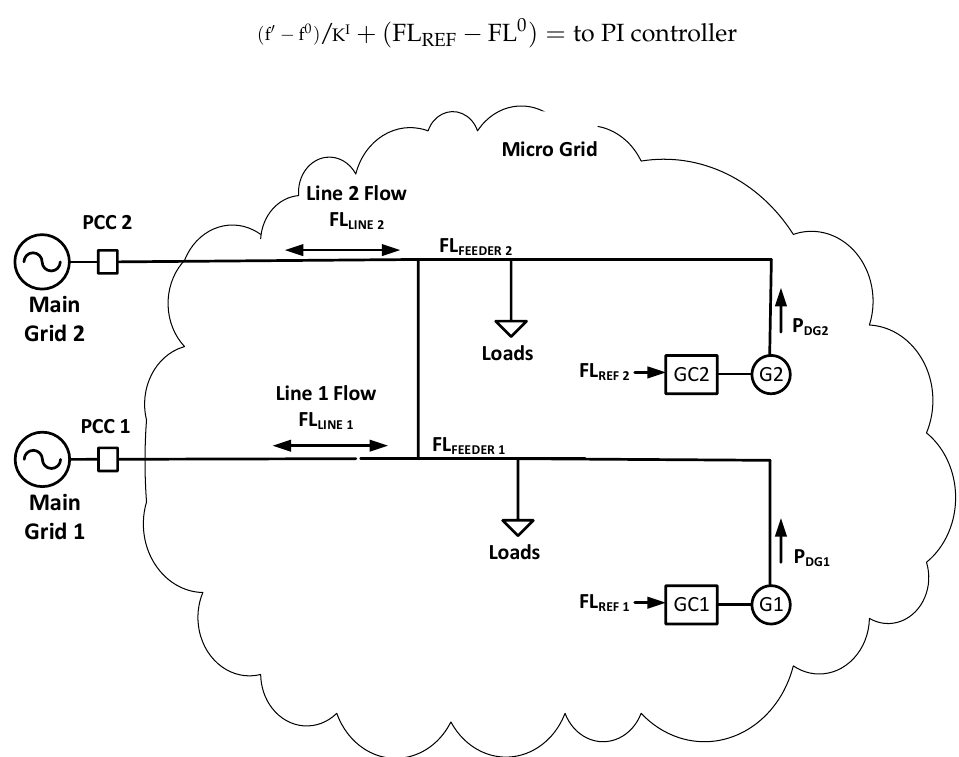
Figure 3. Micro grid with multiple active grid interconnections.